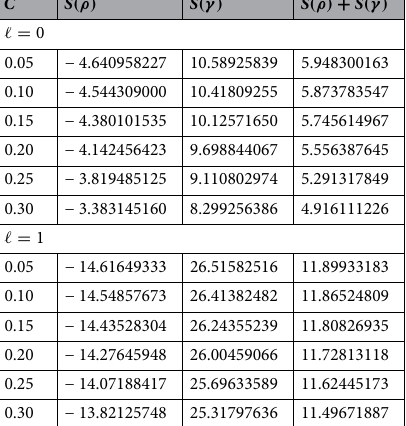
Table 10. Shannon entropy in both position space and momentum space with n = 0, C = D e = 1, r e = 0.2 with two values of the angular momentum quantum number.